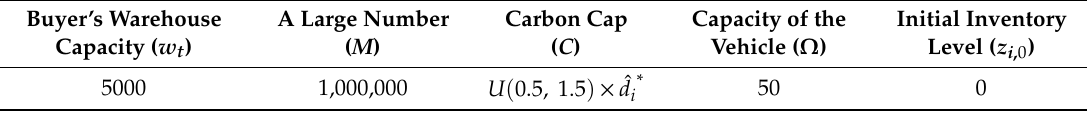
Table 2. Input parameters for the experiment.